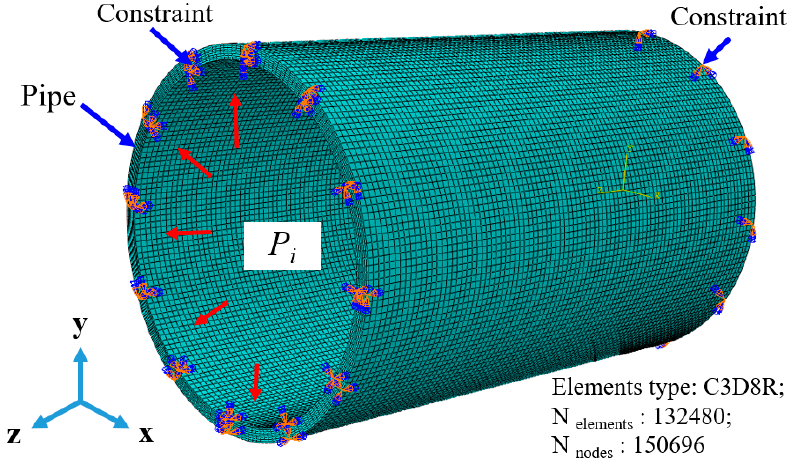
Figure 11. Pipe model and finite-element mesh (P1200-1).